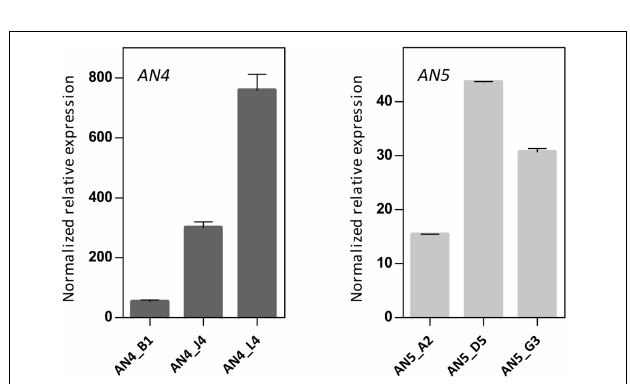
FIGURE 7 | Expression analysis of ArathNictaba overexpression level in 2-week-old 35S:: AN4 and 35S:: AN5 transgenic lines. Normalized relative expression of AN4 and AN5 compared to WT plants ( N = 1). Error bars represent standard